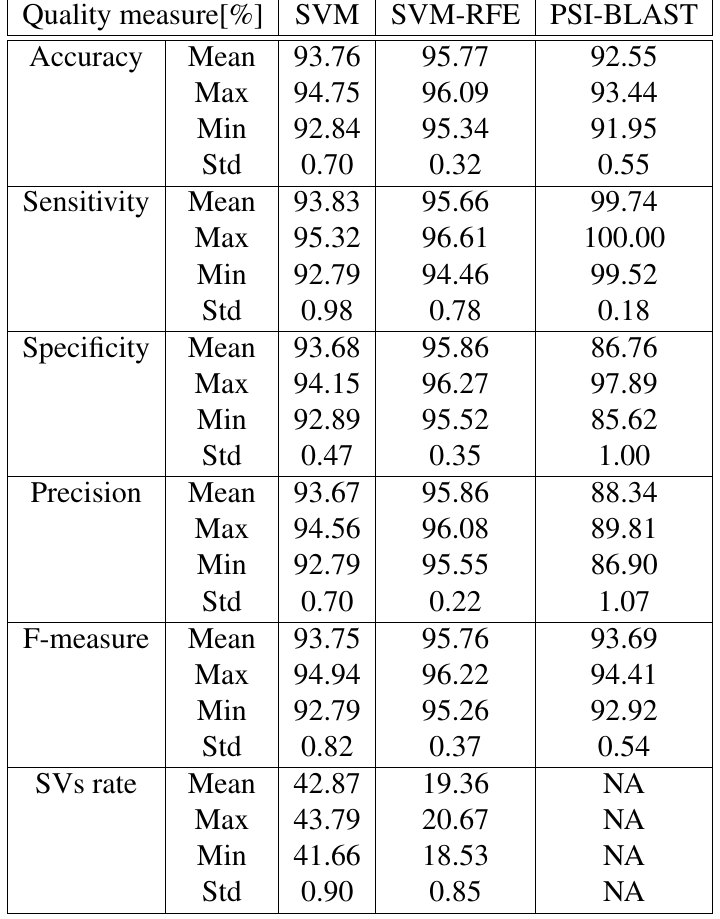
Table 2: Best results for the algorithms studied during the development of the peptidase detector: SVM (without feature selection), SVM-RFE (148 features) and PSI-BLAST. The parameter ’SVs rate’ refers to the rate of train examples kept as support vectors by a trained model, which is not applicable (NA) to PSI-BLAST. Mean, Max, Min and Std, stand respectively for the mean, the maximum, the minimum and the standard deviation of the quality metric determined from the 5-fold cross-validation procedure accomplished.